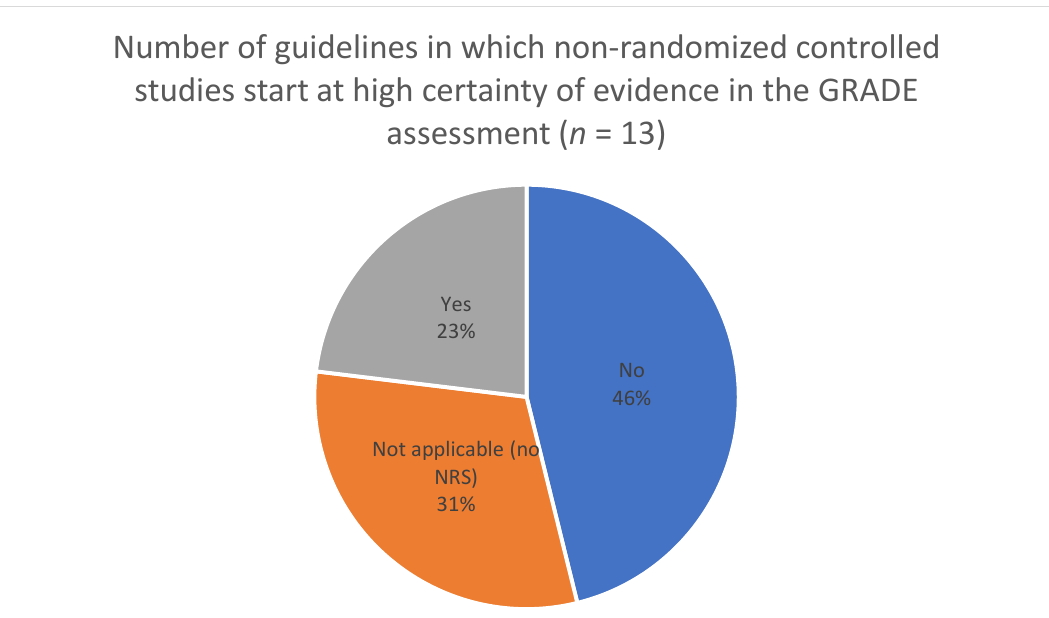
Figure 4. Moderate or high certainty of evidence rating based on non-randomized studies.